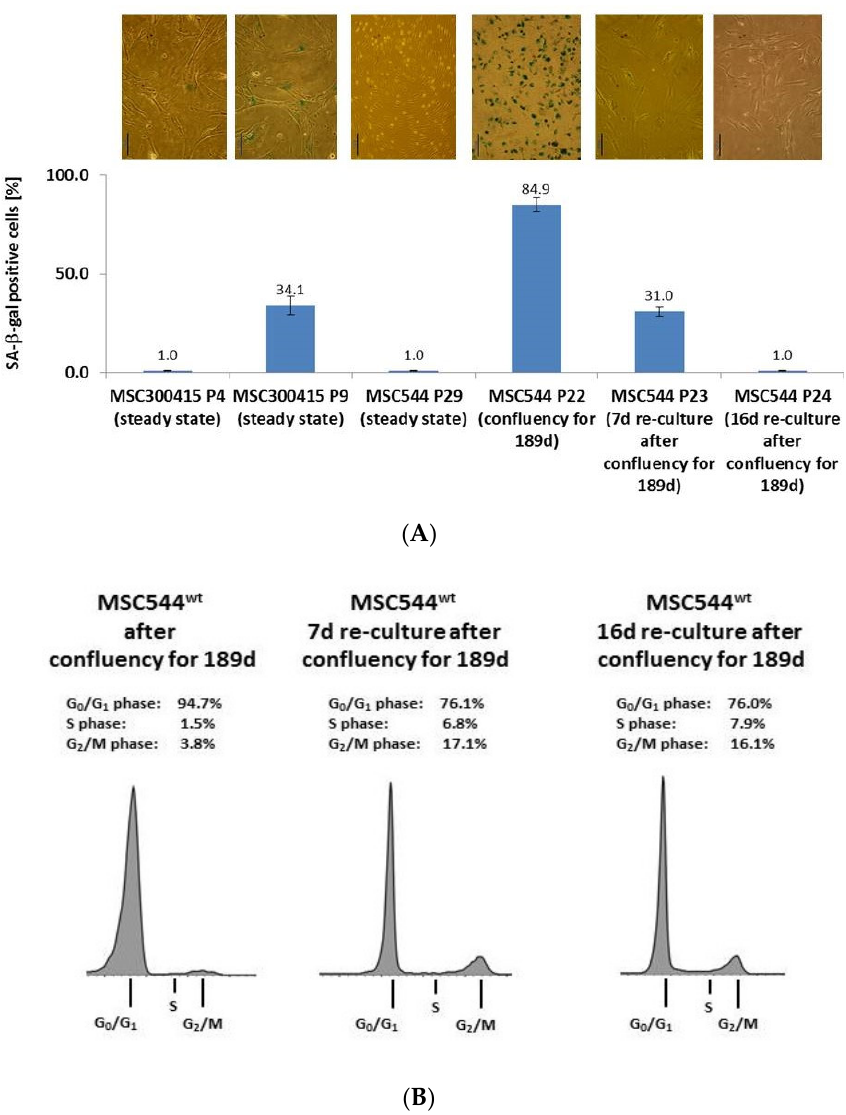
Figure 3. ( A ) Expression of senescence-associated beta galactosidase (SA- β -gal) was monitored for enzymatic activity after processing the substrate 5-bromo-4-chloro-3-indolyl- β D-galactopyranoside to obtain blue colored cells via light microscopy (upper panel, bars represent 100 µ m). These were quantified by the percentage of SA- β -gal-positive cells in UC-MSC300415 in a low (P4) and high (P9) passage compared to MSC544 in P29. Moreover, SA- β -gal expression was evaluated in MSC544 P22 grown in confluency for 189d without subculturing and compared to MSC544 grown in confluency for 189d and subcultured for additional 7d in P23 and 16d in P24, respectively. Data represent the mean + s.d. ( n = 3). ( B ) Cell cycle analysis was performed in MSC544 P22 grown in confluency for 189d without subculture and compared to MSC544 grown in confluency for 189d and subcultured for additional 7d in P23 and 16d in P24,